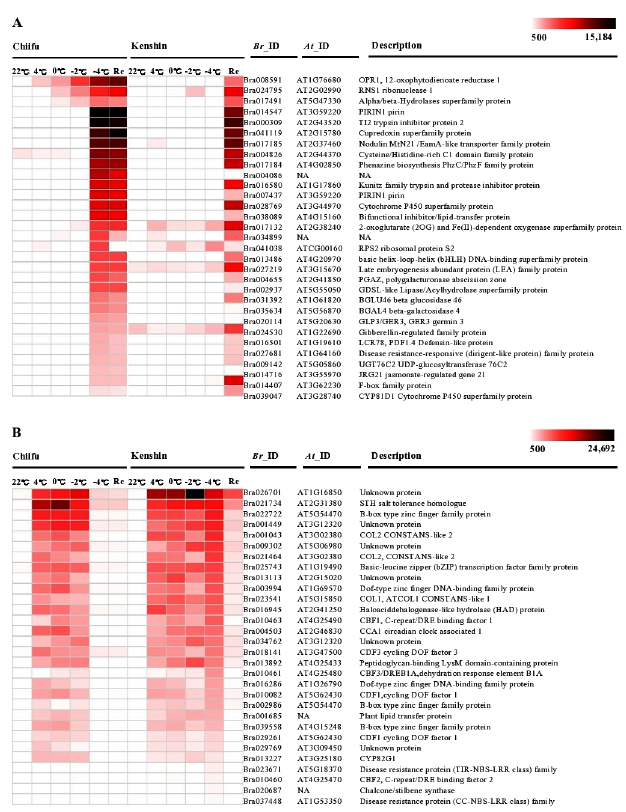
Figure 4. Transcriptome analyses of Chiifu and Kenshin shown by heat maps. Heat maps of expression profiles of top-30 ranked induced genes upon 2 4 u C treatment in Chiifu (A) and Kenshin (B) were compared. Absolute expression values are scaled by PI values. Detailed transcriptome information was described in Table S9 for Chiifu and Table S10 for Kenshin. doi:10.1371/journal.pone.0106069.g004 PLOS ONE |